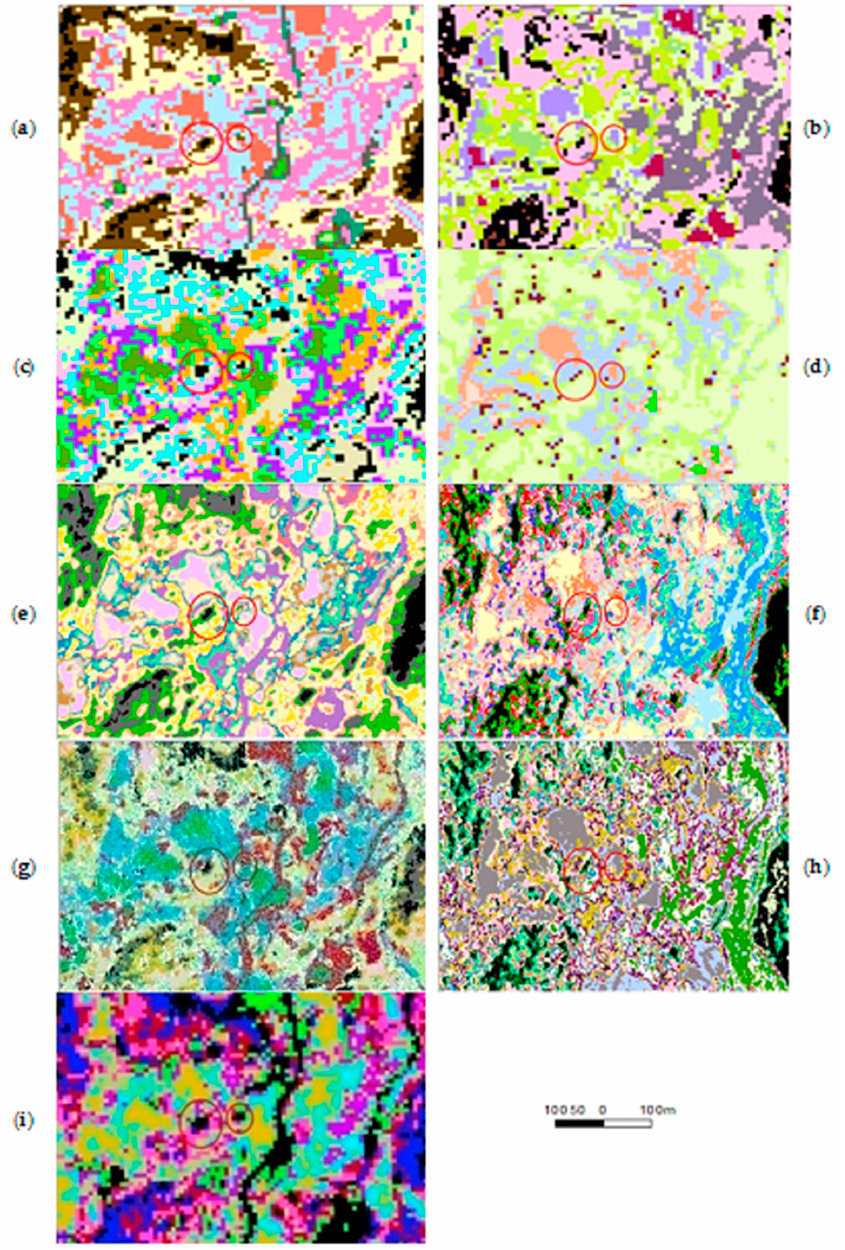
Figure 9. ISODATA classification for Greek study areas; ( a ): unsupervised classification using Sentinel-2 RGB image in February, ( b ): unsupervised classification using Sentinel-2 RGB image in August, ( c ): unsupervised classification using Sentinel-2 Composite 3 in February, ( d ): unsupervised classification using Sentinel-2 Composite 3 in August, ( e ): unsupervised classification using Plan- etScope RGB image in February, ( f ): unsupervised classification using PlanetScope RGB image in August, ( g ): unsupervised classification using PlanetScope Composite 3 in February, ( h ): unsuper- vised classification using PlanetScope Composite 3 in August, ( i ): unsupervised classification using Sentinel-2 Composite 1 image in February; OMW disposal areas are indicated inside the red frame.